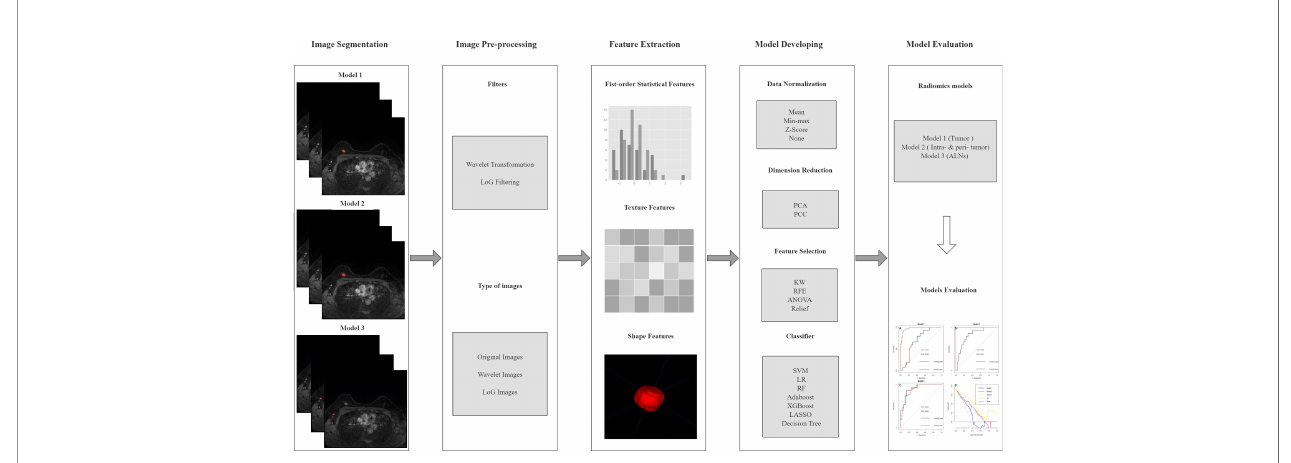
FIGURE 2 | The pipeline of this study. LoG, Laplacian of Gaussian; PCA, principal component analysis; PCC, Pearson ’ s correlation coef fi cient; KW, Kruskal – Wallis; RFE, recursive feature elimination; SVM, support vector machine; LR, logistic regression; RF, random forest; LASSO, least absolute shrinkage and selection operator; ALN, axillary lymph node.